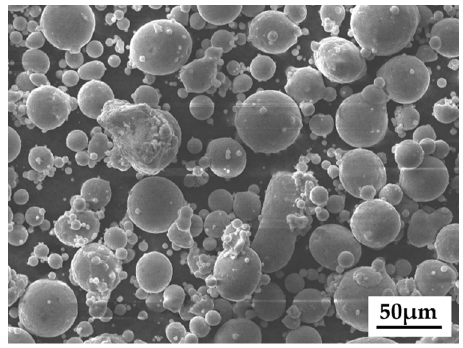
Figure 1. SEM morphologies of Al Si10Mg powder. Table 1. Chemical composition of forming material powder and base materials (wt%).